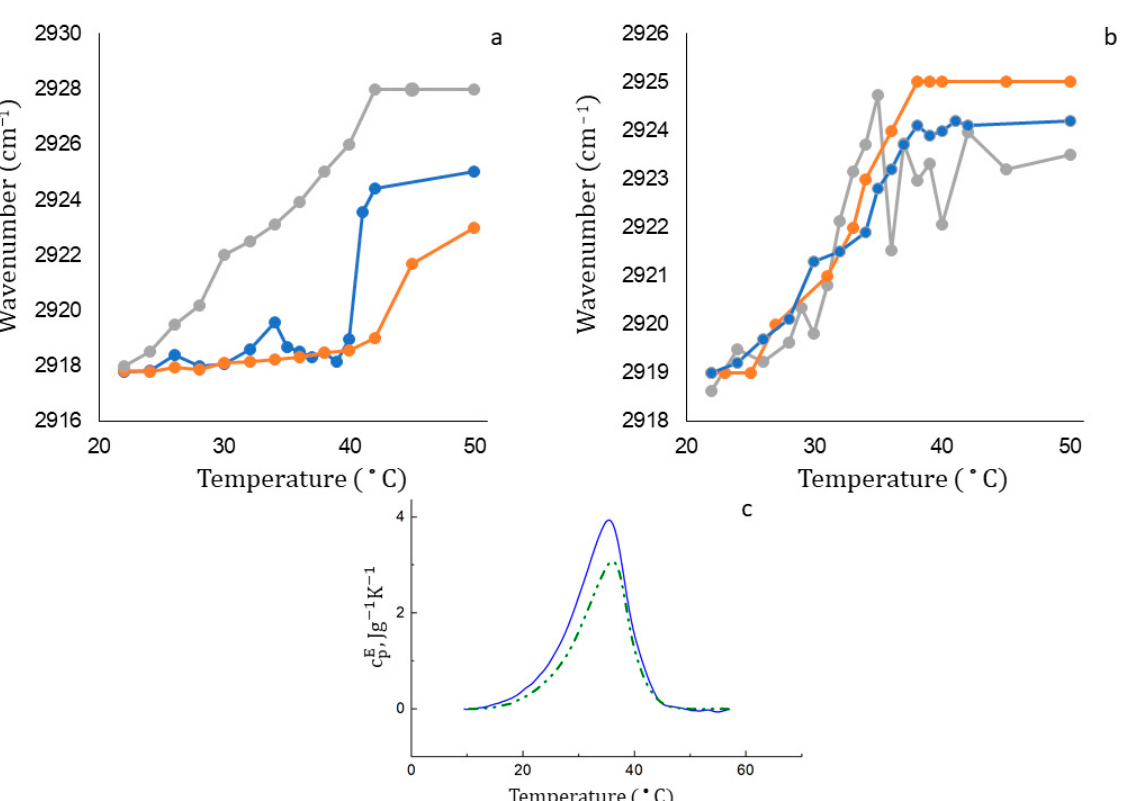
Figure 5. ( a ) Dependence of wavenumber of ν CH 2 as peak position on the temperature for DPPC liposomes (ginger line) and DPPC-based LRif (blue line) and LLev (gray line). For each point, SD = 0.5 cm − 1 ( n = 3). ( b ) Dependence of wavenumber of ν CH 2 as peak position on the temperature for DPPC:CL 80:20 (weight%) liposomes (ginger line) and DPPC:CL-based LRif (blue line) and LLev (gray line). For each point, SD = 0.5 cm − 1 ( n = 3). ( c ) Calorimetric curves of DPPC:CL 80:20 liposomes (blue) and DPPC:CL-based LLev (green). Total lipid concentration 5 mg/mL, 0.02 M PBS pH 7.4.